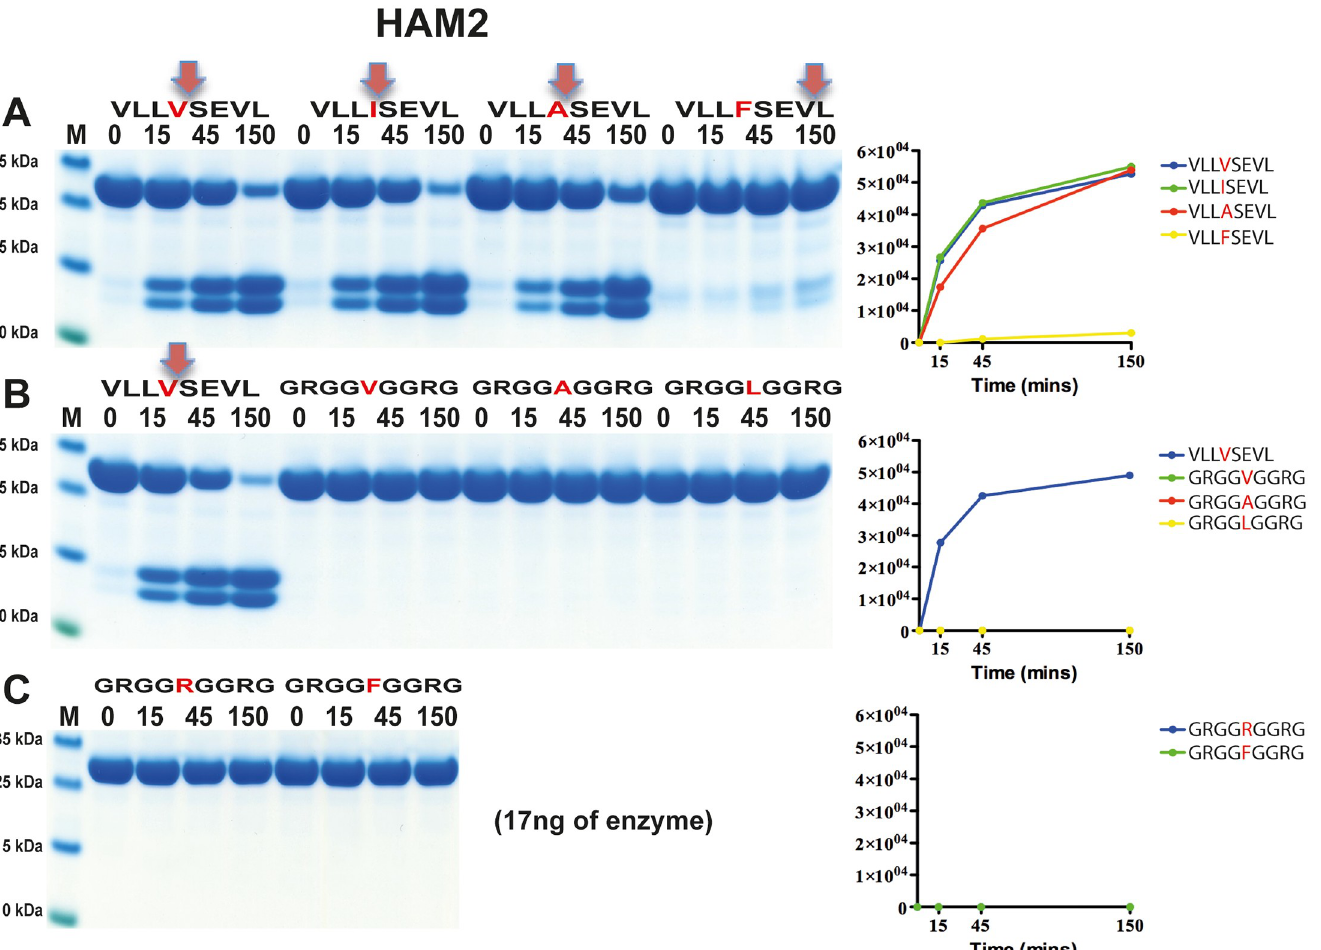
Fig 9. Analysis of the cleavage specificity of HAM2 by the use of recombinant protein substrates. Substrate sequences are indicated above the gel images. The time of cleavage in minutes is indicated above the corresponding lanes of the different gels. The uncleaved substrates have a molecular weight of ~25 kDa and the cleaved substrates appear as two close bands with a size of 12–13